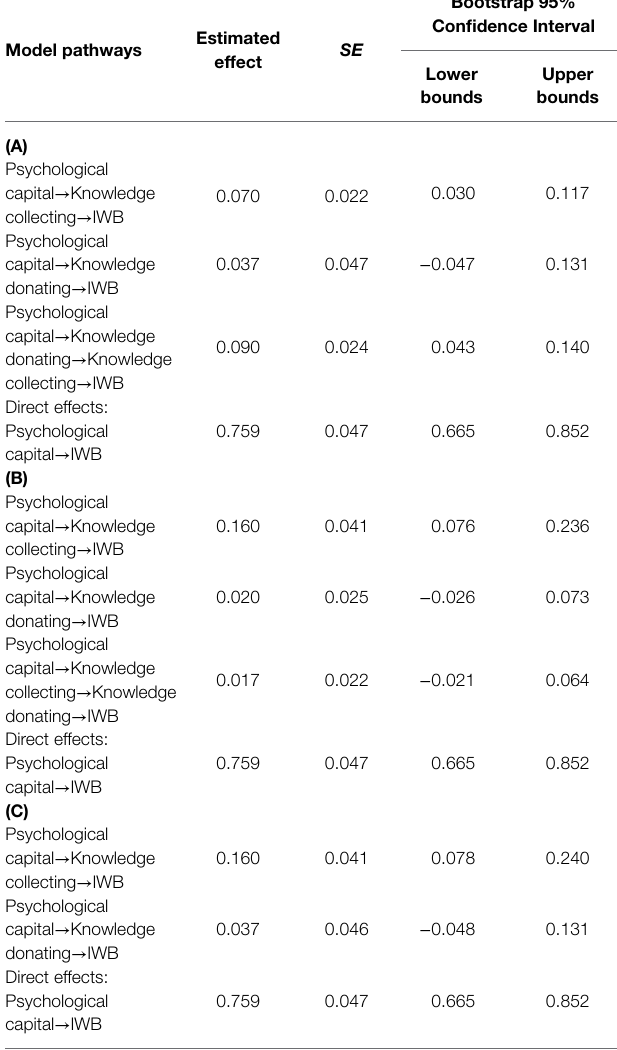
TABLE 2 | Chain mediating effect analysis.